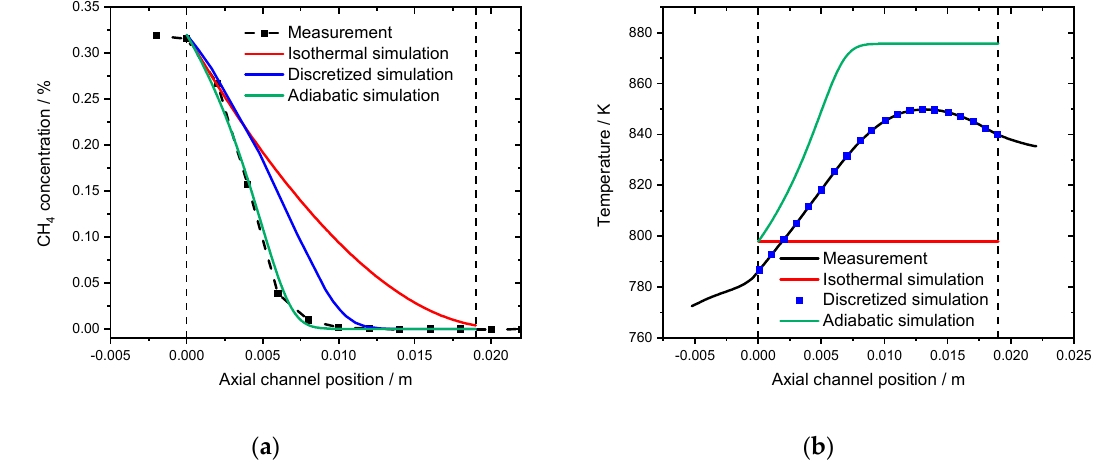
Figure 11. ( a ) Spatially resolved concentration profile at 798 K for the measurement (black line), the isothermal model (red line), the discretized simulation using the temperature profile (blue line) and the adiabatic simulation (green line) in the presence of 12% externally dosed water. 3200 ppm CH 4 , 12% H 2 O, 10% O 2 in N 2 . ( b ) Associated spatially resolved temperature profiles for the experiment (black line), the simulated adiabatic profile (red line) in comparison to the isothermal simulation (blue line) for the measurement in presence of water at 798 K in 3200 ppm CH 4 , 12% H 2 O 10% O 2 in N 2 .). GHSV = 30,000 h − 1 .